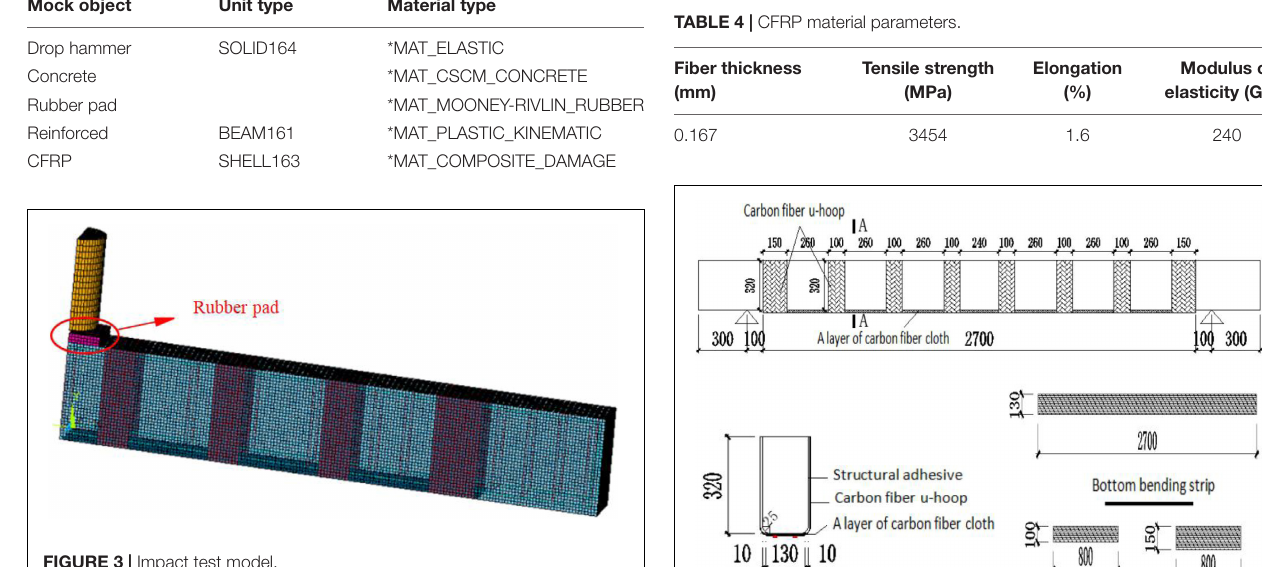
FIGURE 3 | Impact test model.